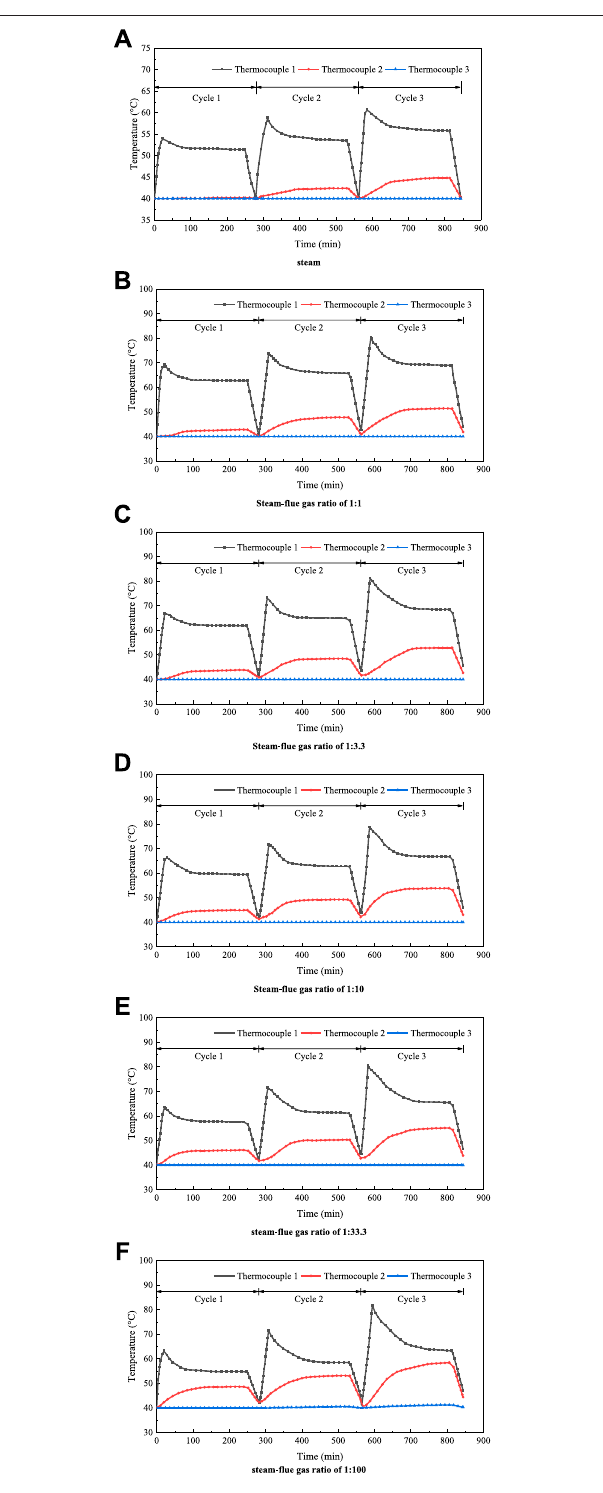
FIGURE 3 | Changes in sandpack temperature for three thermocouples withdifferentsteam- fl uegasratios. (A) Puresteam. (B) Steam- fl uegasratioof 1:1. (C) Steam- fl ue gas ratio of 1:3.3. (D) Steam- fl ue gas ratio of 1:10. (E) Steam- fl ue gas ratio of 1:33.3. (F) Steam- fl ue gas ratio of 1:100.